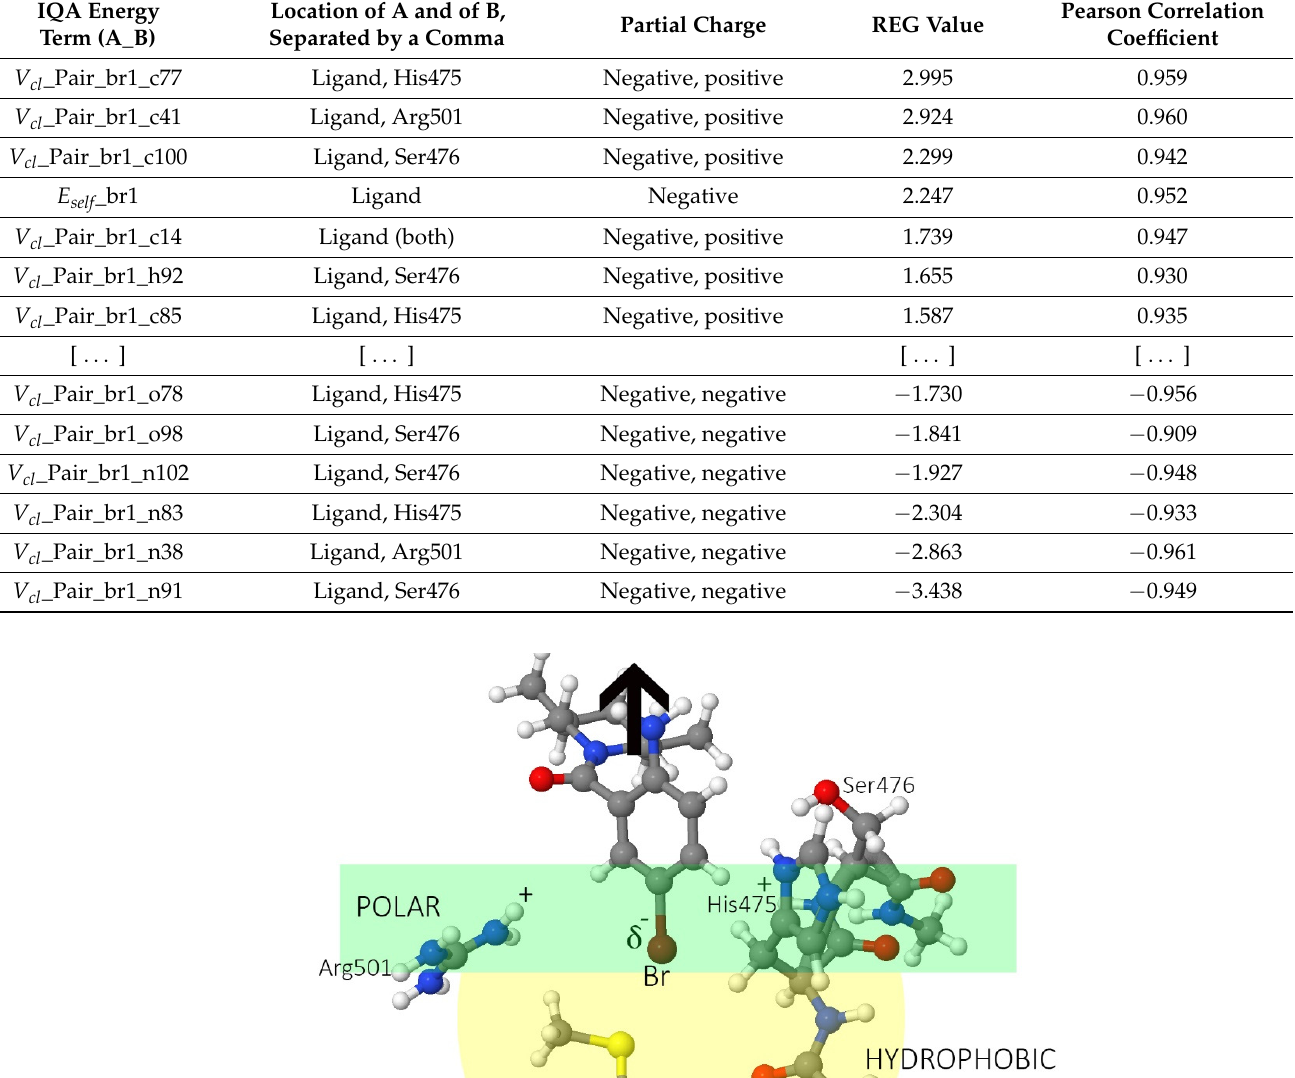
Table 8. The top pairwise interaction terms involving the bromine atom ( A-B ranking), for seg- ment 3 in 3CJ2, in favour of the system’s behaviour (top part) and against the system’s behaviour (bottom part).